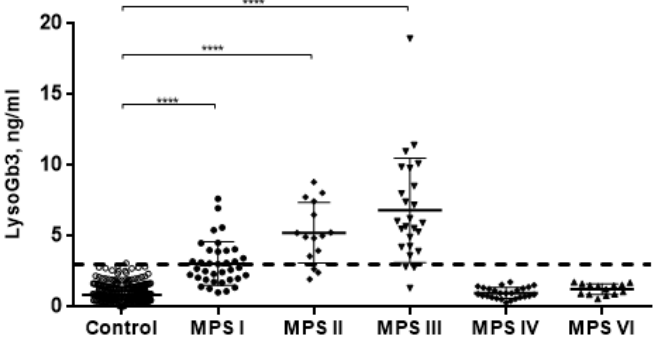
Figure 1. LysoGb3concentrationinnormalcontrolsandpatientswithdifferenttypesofmucopolysaccharidoses Figure 1. LysoGb3 concentration in normal controls and patients with different types of (MPSs) (dotted line-cut-off for LysoGb3 level). **** p < mucopolysaccharidoses (MPSs) (dotted line-cut-off for LysoGb3 level). **** p < 0.0001.